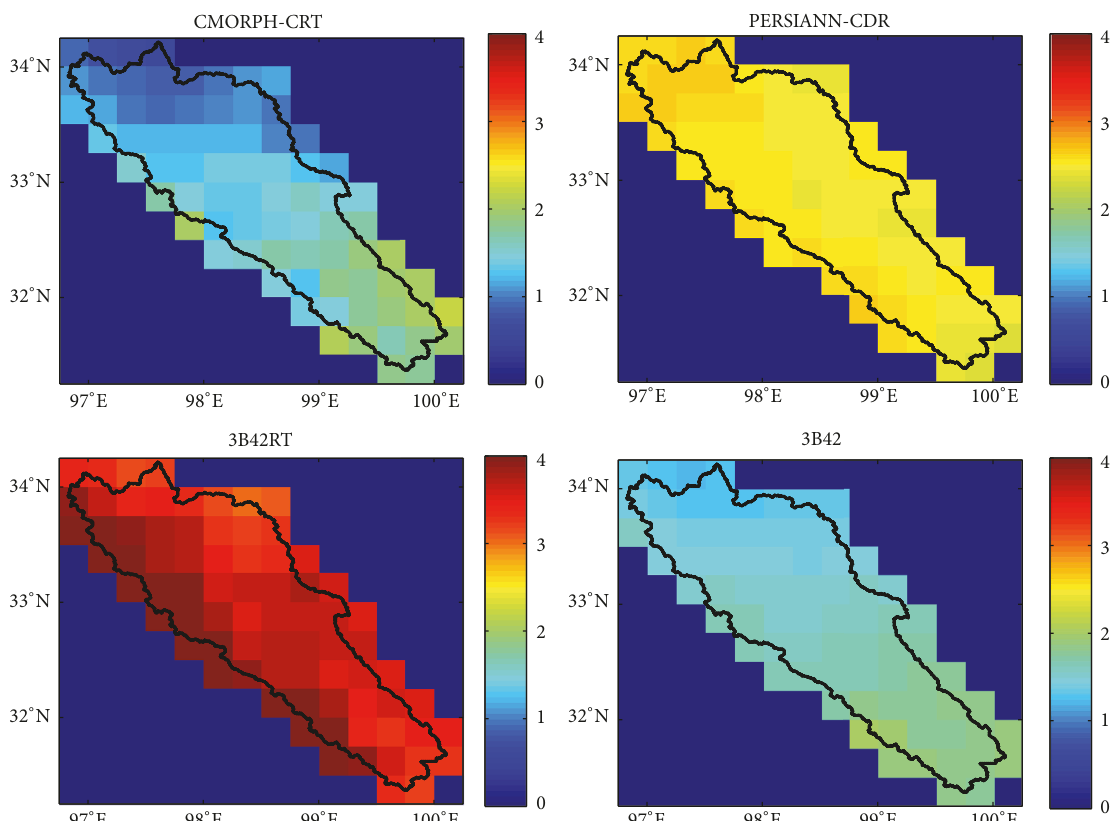
Figure 3: Maps of six-year daily average precipitation (mmday −1 ) at 0.25 ∘ resolution derived from CMORPH-CRT, PERSIANN-CDR, 3B42RT, and 3B42 estimates over GRB during the period 2008 to